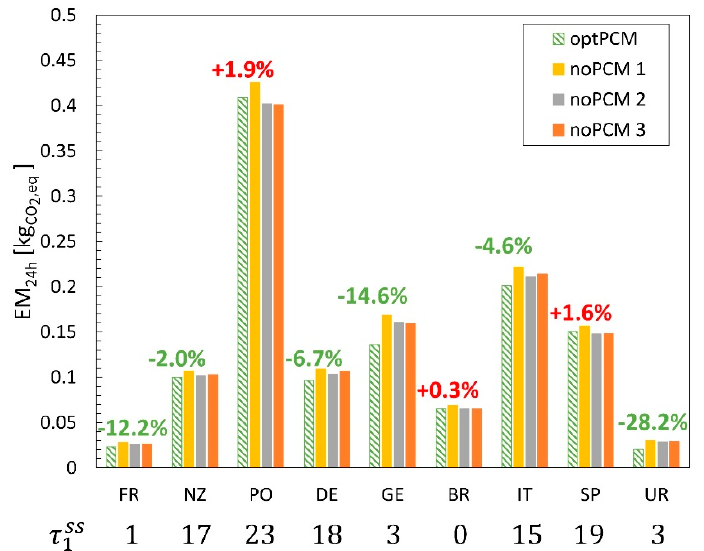
Figure 6. Comparison of carbon emission of the refrigerator with and without PCM among different case studies with the best initial condition. The percentage values above each bar represent the differ- ence between the optimal hysteresis scheduling, optimizing daily carbon emission. The minimum daily carbon emission obtained simulates the refrigerator without PCM with a fixed hysteresis.